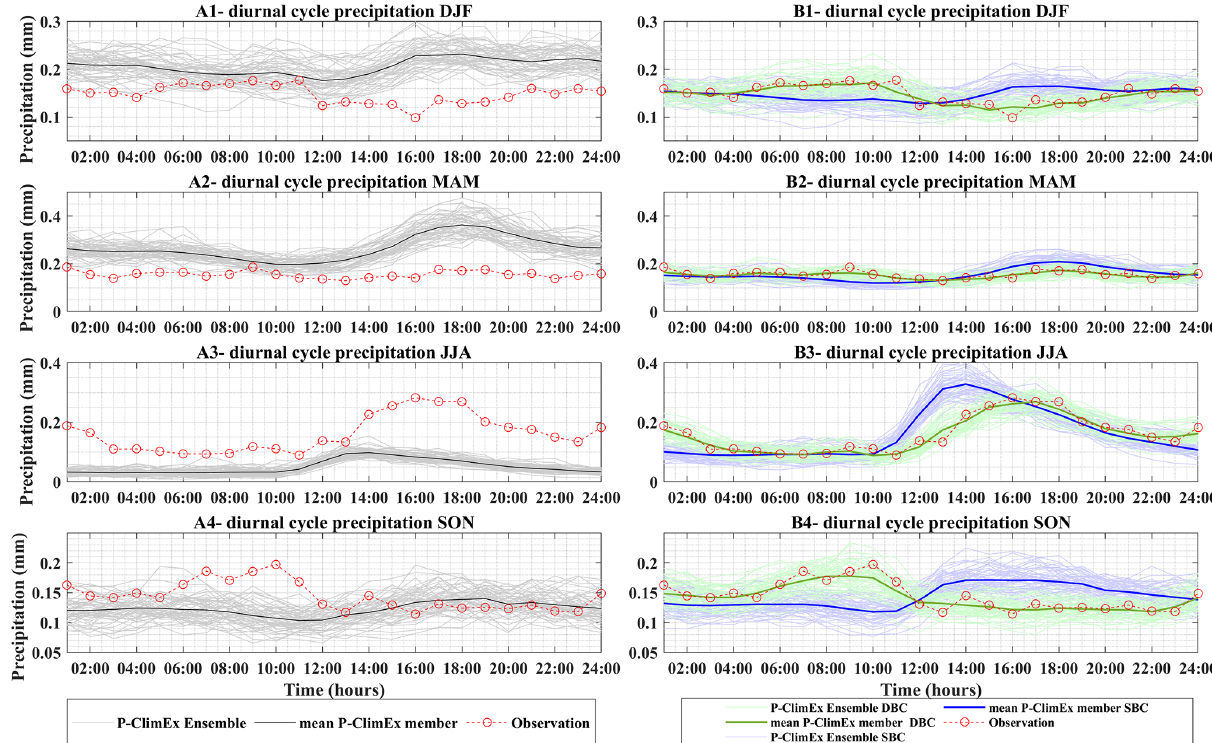
Figure 4. Annual diurnal cycle of precipitation before bias correction (left column: A1 to A4) and after bias correction (right column: B1 to B4) for catchment 02143040. Each row corresponds to a different season: DJF (December, January, February), MAM (March, April, May), JJA (June, July, August), and SON (September, October, November). The right hand side shows both bias-correction methods: standard bias correction (SBC) and diurnal bias correction (DBC). The observations are shown in red. Raw (uncorrected) ClimEx data are in gray, SBC is in blue, and DBC is in green. The envelopes defined by all 50 ClimEx members are shown in the corresponding light colors, whereas the dark colored lines display the ensemble mean. Time shown is local time, with 24:00 corresponding to